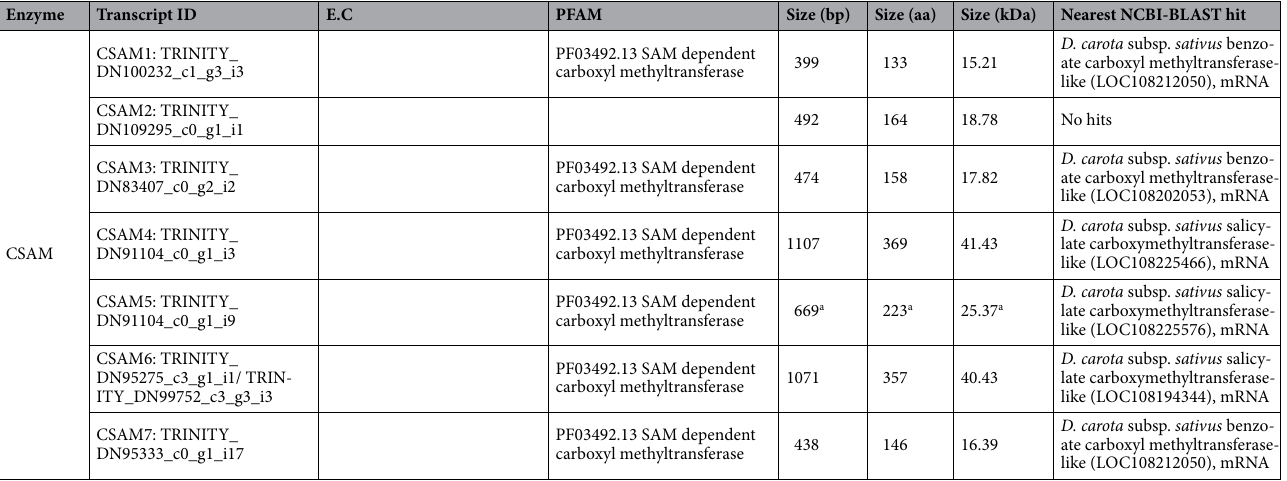
Table 1. Top in silico candidates for PKR, AAT, CR, and CSAM of coniine biosynthesis. Transcript ID shows the identifier of the transcript obtained in Trinity assembly. Enzyme commission number (E.C.) and protein family identifier (PFAM) were derived using the annotation approach described in the manuscript. The Size (bp) and Size (aa) show the size of the transcript in terms of nucleotide and predicted amino acid sequence. The molecular weight was predicted from the peptide sequence as described in the manuscript. a Incomplete sequence.